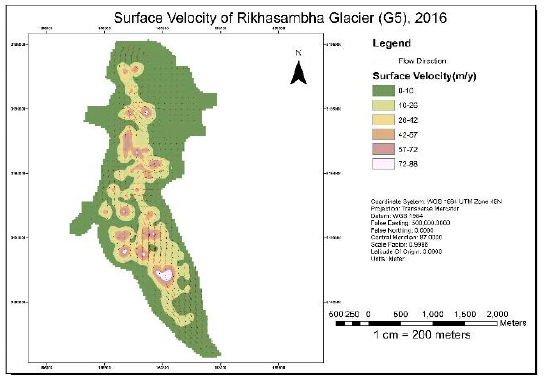
Figure 2. Surface Velocity of Rikhasambha (G5) at 2006.